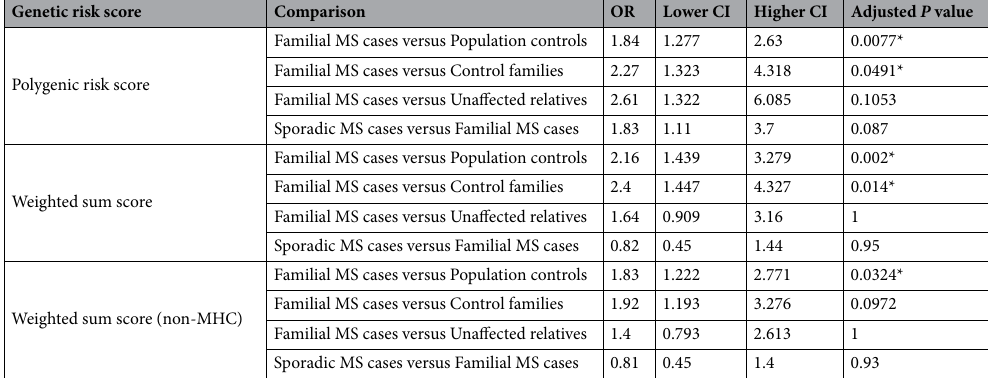
Table 2. Association of polygenic risk scores and weighted sum scores with risk of MS. OR, odds ratio (95% confidence intervals [CI]); Adjusted P value, after Bonferroni correction; *, significant.